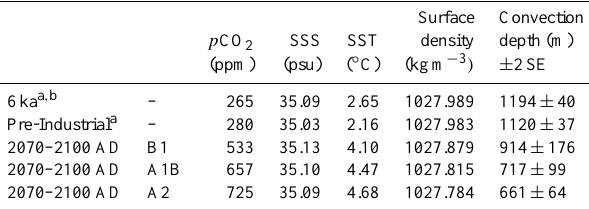
Table 2. Modelled changes in March sea-surface salinity (SSS), temperature (SST), surface density, and maximum winter convec- tion depth over the region 15–20 ◦ E, 76.25–78.75 ◦ N during the Holocene and under future IPCC emission